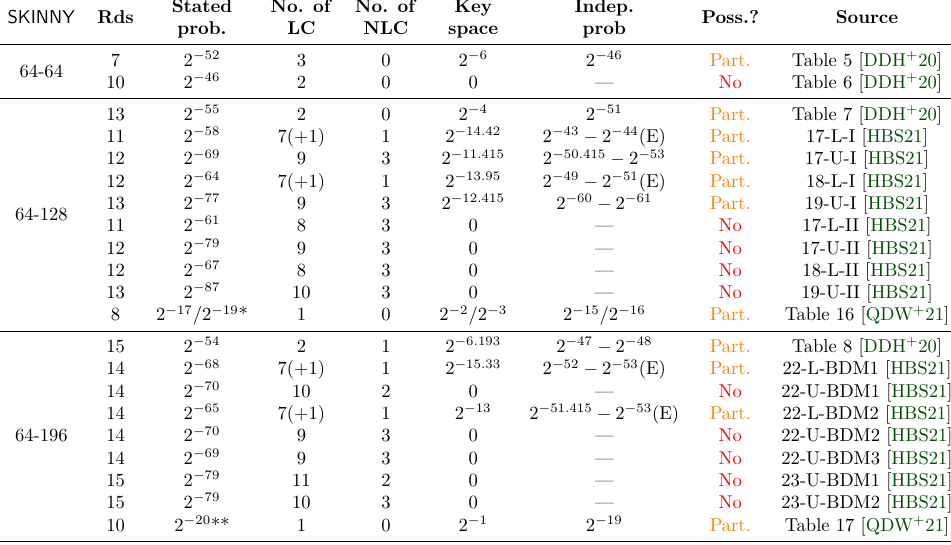
Table 1: The analysis of SKINNY-64 differential characteristics. “Stated prob.” refers